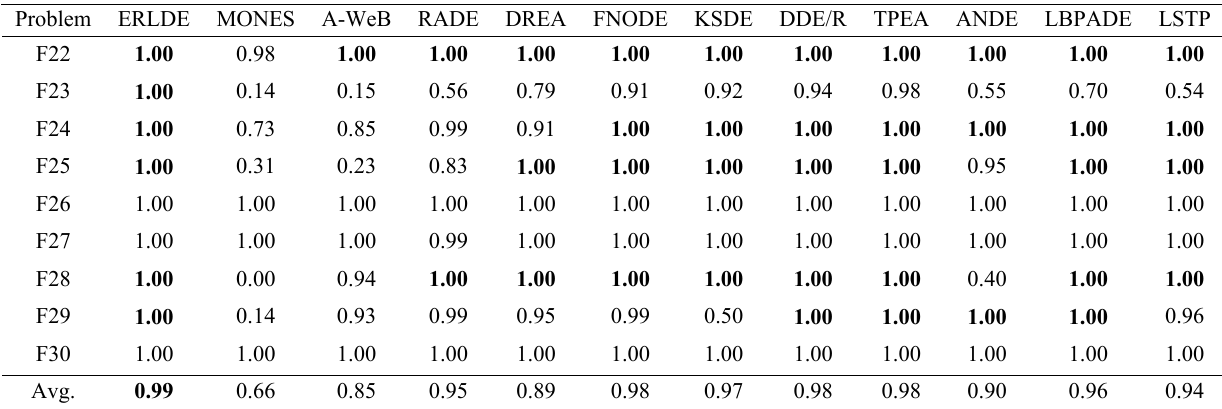
Table A2 Comparison between ERLDE and other algorithm with respect to RR .